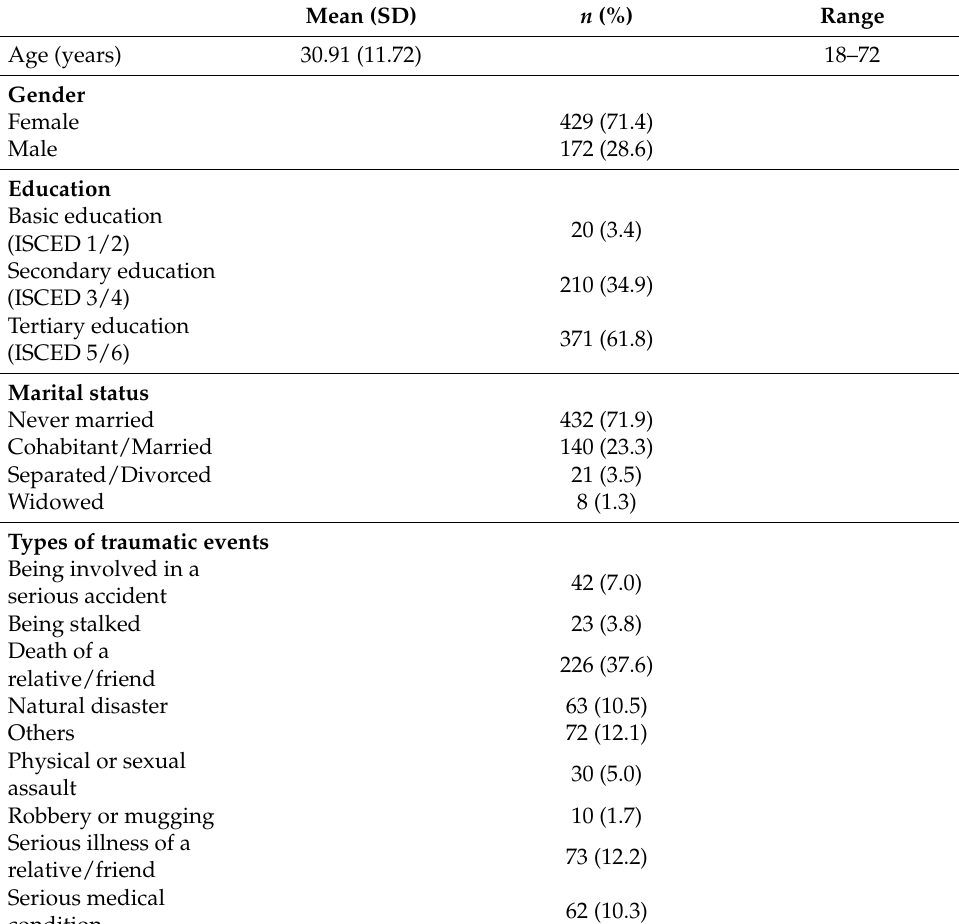
Table 1. Sociodemographic and trauma-related data of the Italian participants ( N =